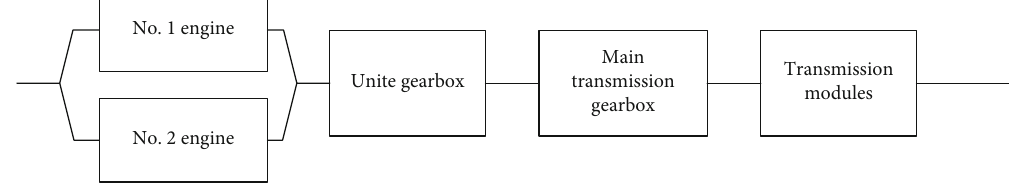
Figure 1: Con fi guration of helicopter power transmission system.